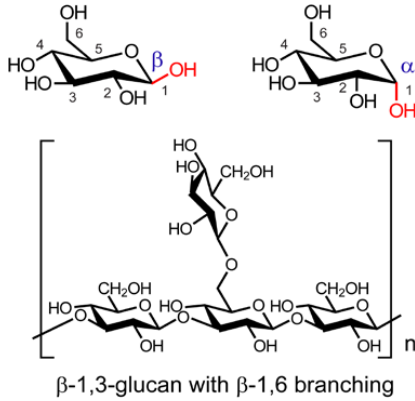
Figure 4. Basic structure of a typical mushroom polysaccharide. Variations include 1 → 4 linkages, α -glucan moieties, and alternate sugars.